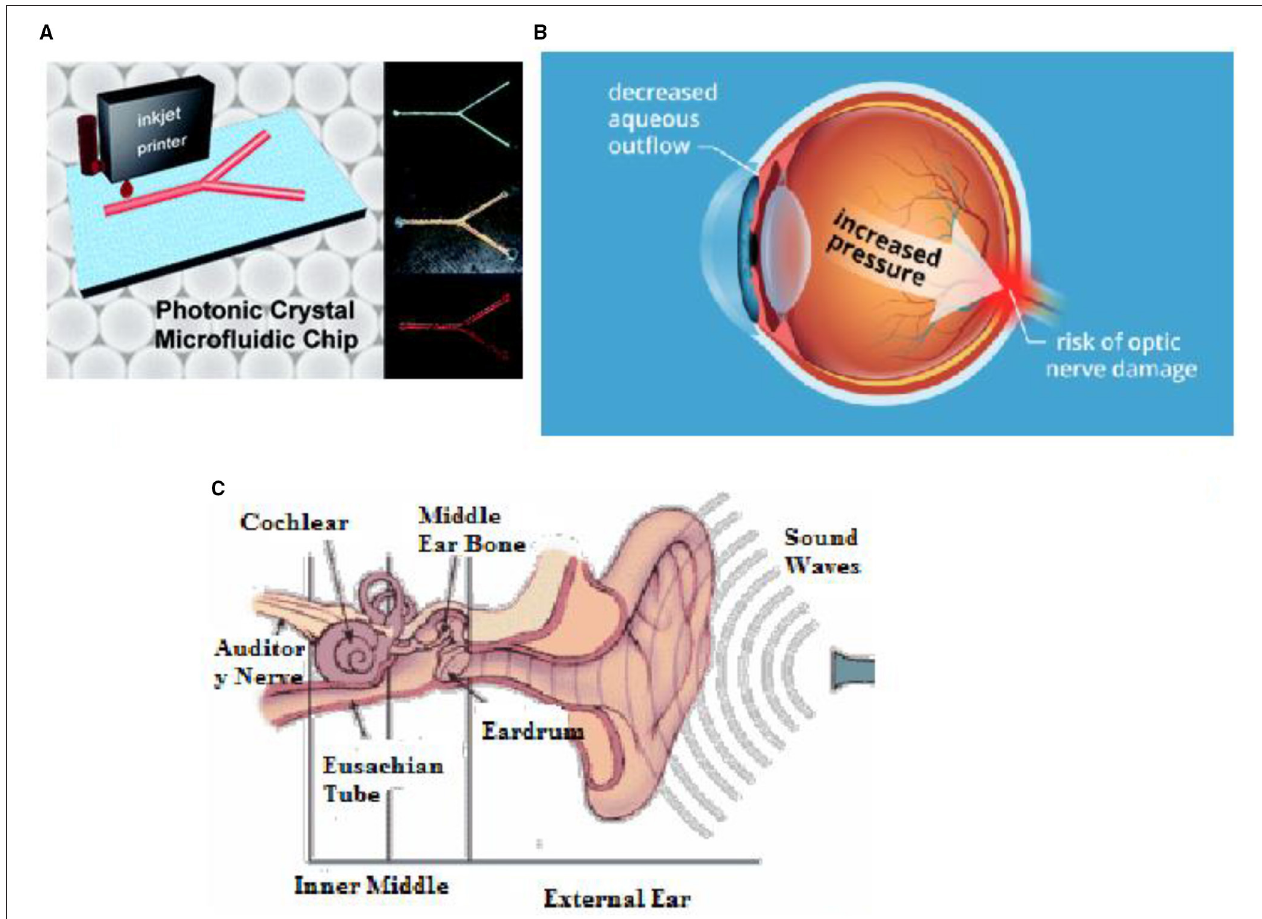
FIGURE 10 | (A) Microfluidic channel with photonic crystal integration (81). (B) Intraocular pressure development in the eye (82). (C) Human cochlear system